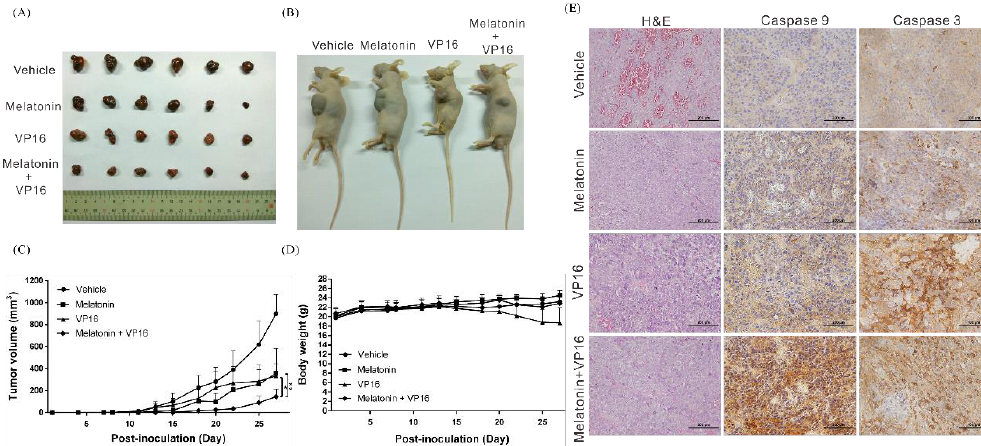
Figure 3. Melatonin suppressed tumor growth and enhanced etoposide (VP16)-induced inhibitory effects on tumors in vivo. ( A,B ) A total of 5 × 10 6 Huh7 cells were injected subcutaneously into both the right and left flanks of nude mice ( n = 6, each group). Representative images show the tumor xenografts after 4 weeks. ( C ) Tumor volumes were measured three times a week and calculated using the formula: length × width 2 × 0.5. Bars indicate S.D. * p < 0.05, ** p < 0.01. ( D ) Body weights were recorded three times a week. ( E ) Histological analysis of xenografts using H&E staining and